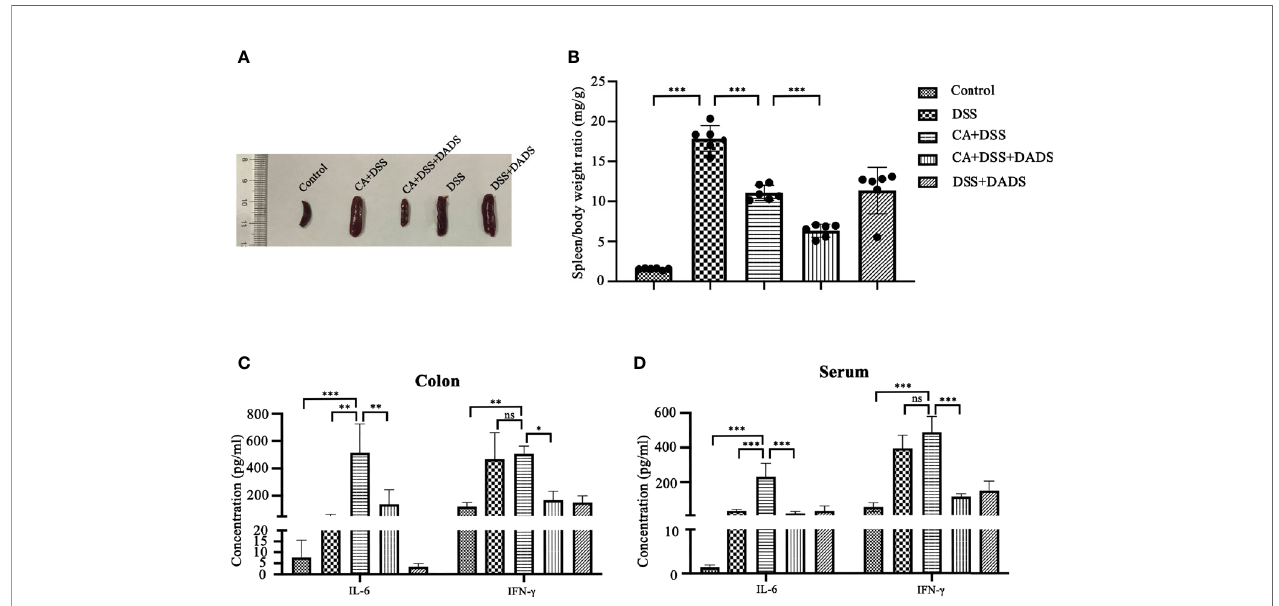
FIGURE 4 | DADS exhibited an anti-in fl ammatory effect in mice with C. albicans infection. (A, B) Spleen size and the spleen/body weight ratio. (C, D) The concentrations of IL-6 and IFN- g in the colon and